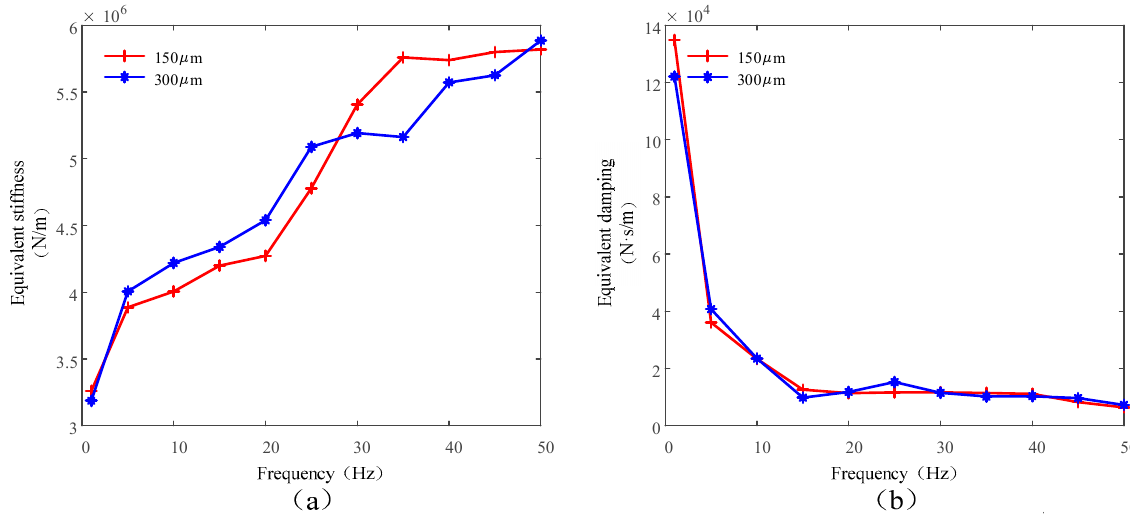
Figure 9. Dynamic parameters of specimen X01 vary with frequency: ( a ) equivalent stiffness, and ( b ) equivalent damp ‐ ing.